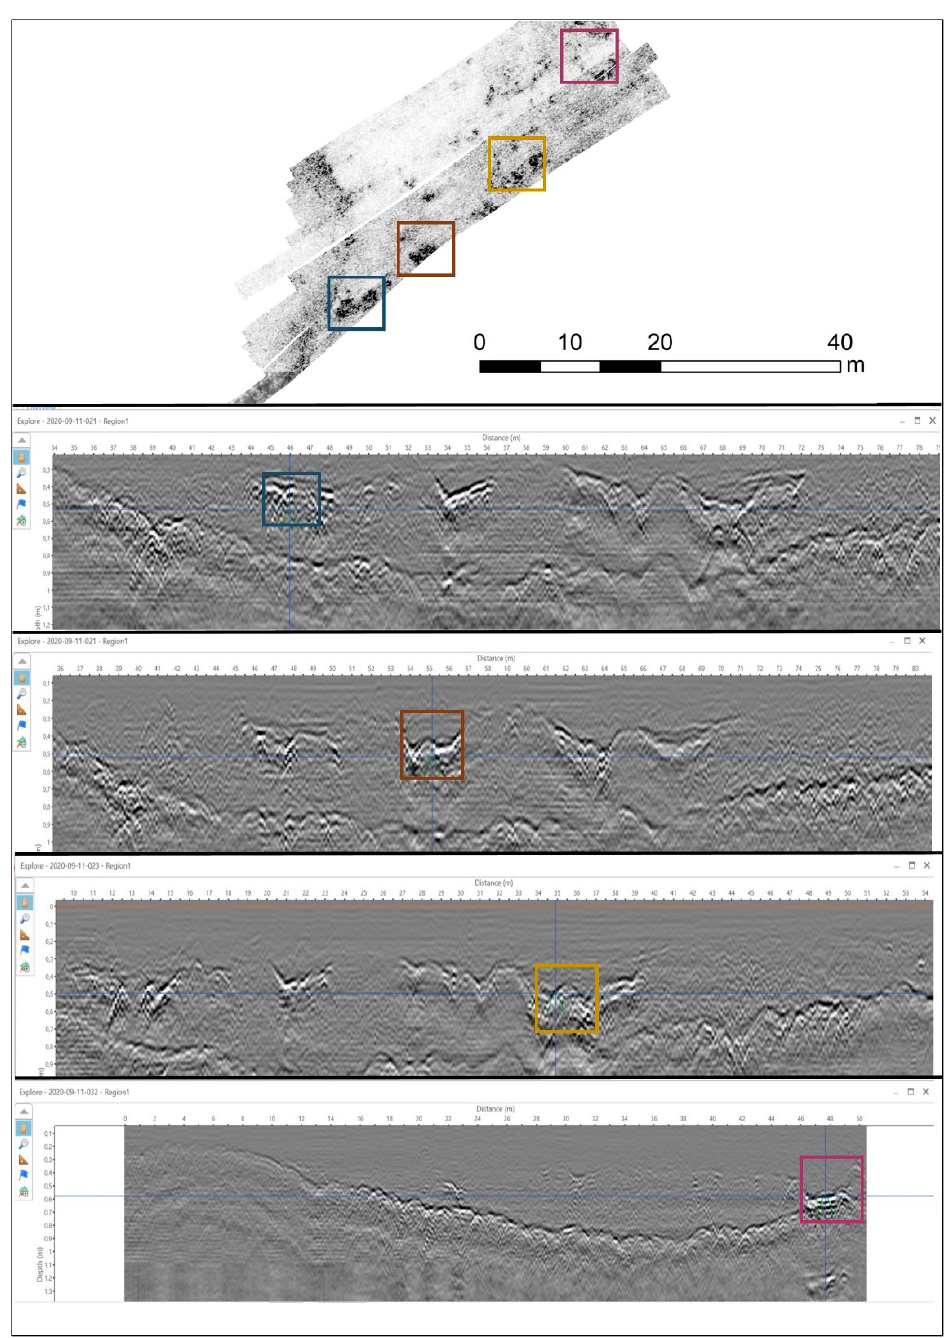
Figure 10. Main alterations of the GPR survey of the necropolis. The group identified in the north (P1-1) contains a series of linear anomalies running orthogonally to each other. The reflections take on a northeast-southwest and northwest- southeast orientation, hence the same as the urbanism interpreted in the area described above. The anomalies are visualised very subtly and, according to the radargrams, at a shallow level of little over 20 cm. Following detailed analysis, there emerges a subset to the north with a rectangular morphology and outlining a space of 7 × 8 m. We may highlight a possible floor or pavement in this area, and another space about 30 m to the south, the main construction, which presents internal subdivisions forming practically square 4 × 4 m rooms, and finally, to the southwest, already in the neighbouring plot, another group at a greater depth and which seem to form the perimeter closure of the set or building on